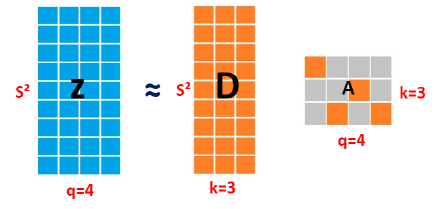
Figure 2. Dictionary learning process.